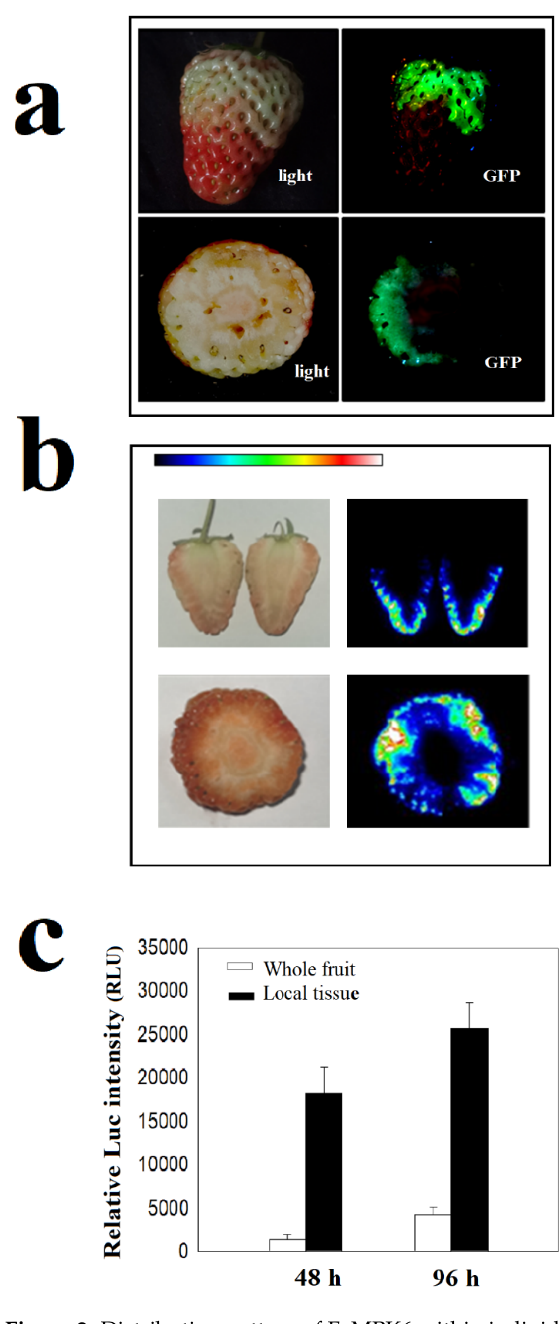
Figure 2. Distribution pattern of FaMPK6 within individual fruit. ( a , b ) detached fruit at the W stage were transformed with A. tumefaciens carrying either FaMPK6: eGFP ( a ) or FaMPK6: Luc ( b ) fusion constructs driven by the pSuper promoter. On day 4 after transformation, imaging was conducted. ( c ) detached fruit at the W stage were transiently transformed with A. tumefaciens carrying a FaMPK6: Luc fusion construct driven by the pSuper promoter. Luc activity was determined 48 h and 96 h after transformation. Whole fruit, protein was extracted from whole fruit; Local tissue, fruit tissue was excised from the areas that had been infiltrated with A. tumefaciens .